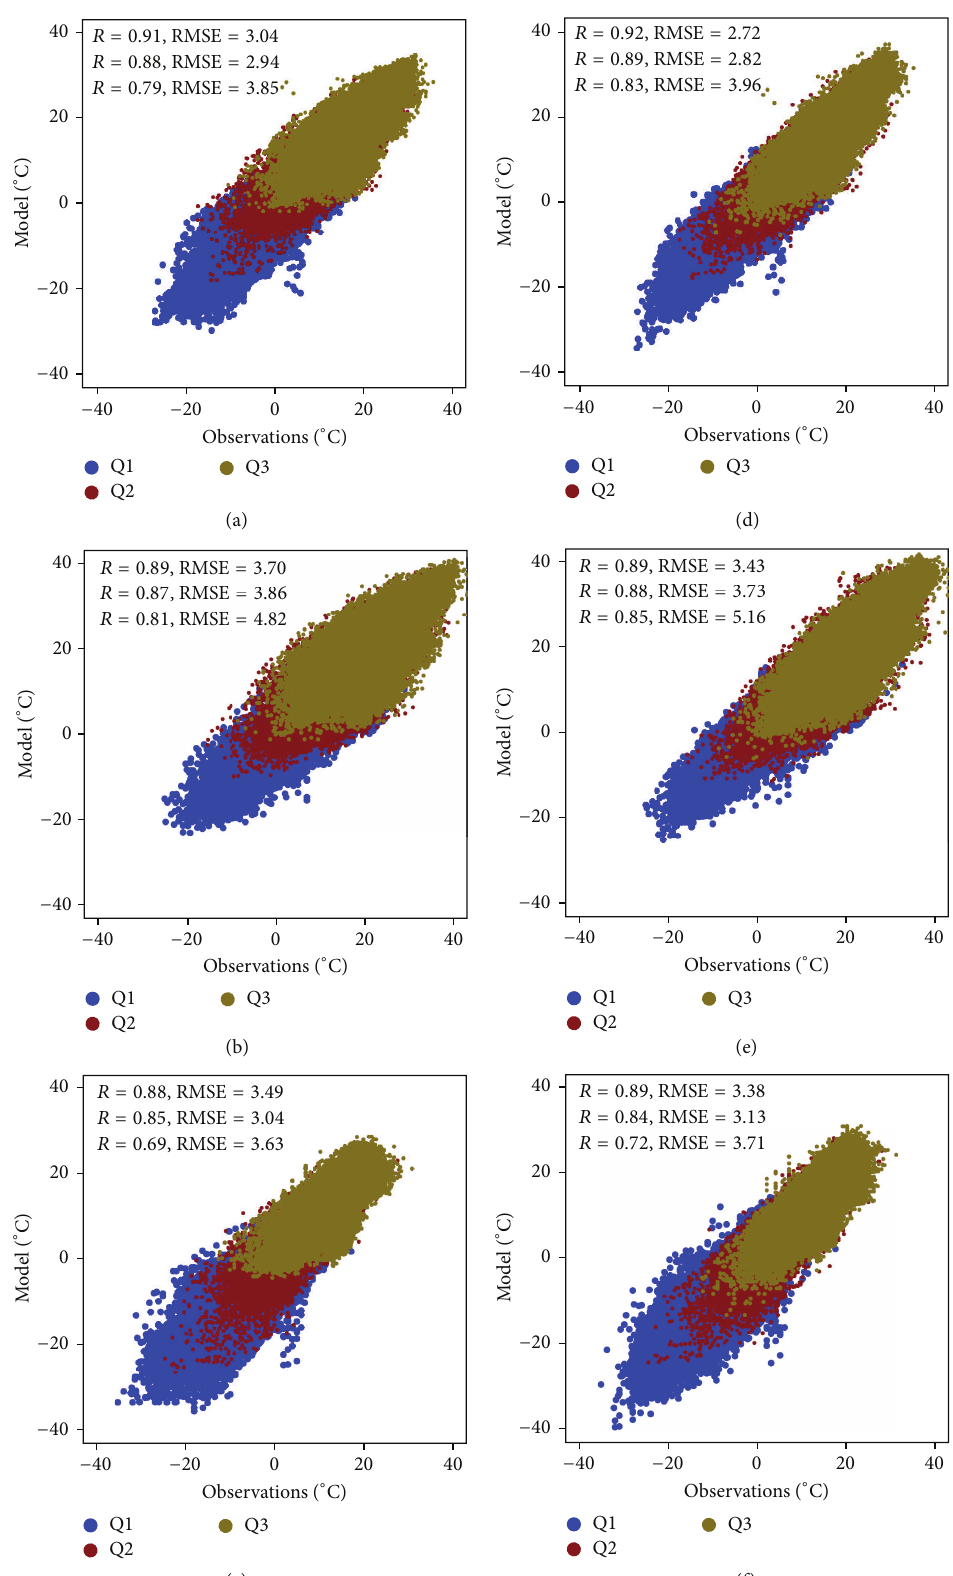
Figure 4: Simulation of daily mean ((a) and (d)), daily max ((b) and (e)), and daily minimum temperatures ((c) and (f)) using WRF-Chem. First column corresponds to WRF-Chem simulations with 36 km resolution and second column to WRF-Chem simulations with 12km